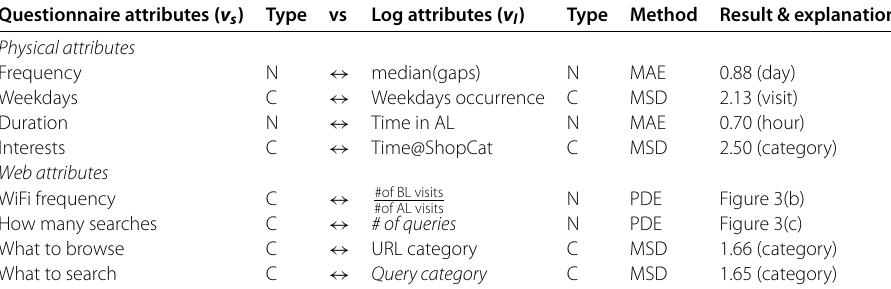
Table 7 Log attributes vs questionnaire attributes Questionnaire attributes ( v s ) Type vs Log attributes ( v l )